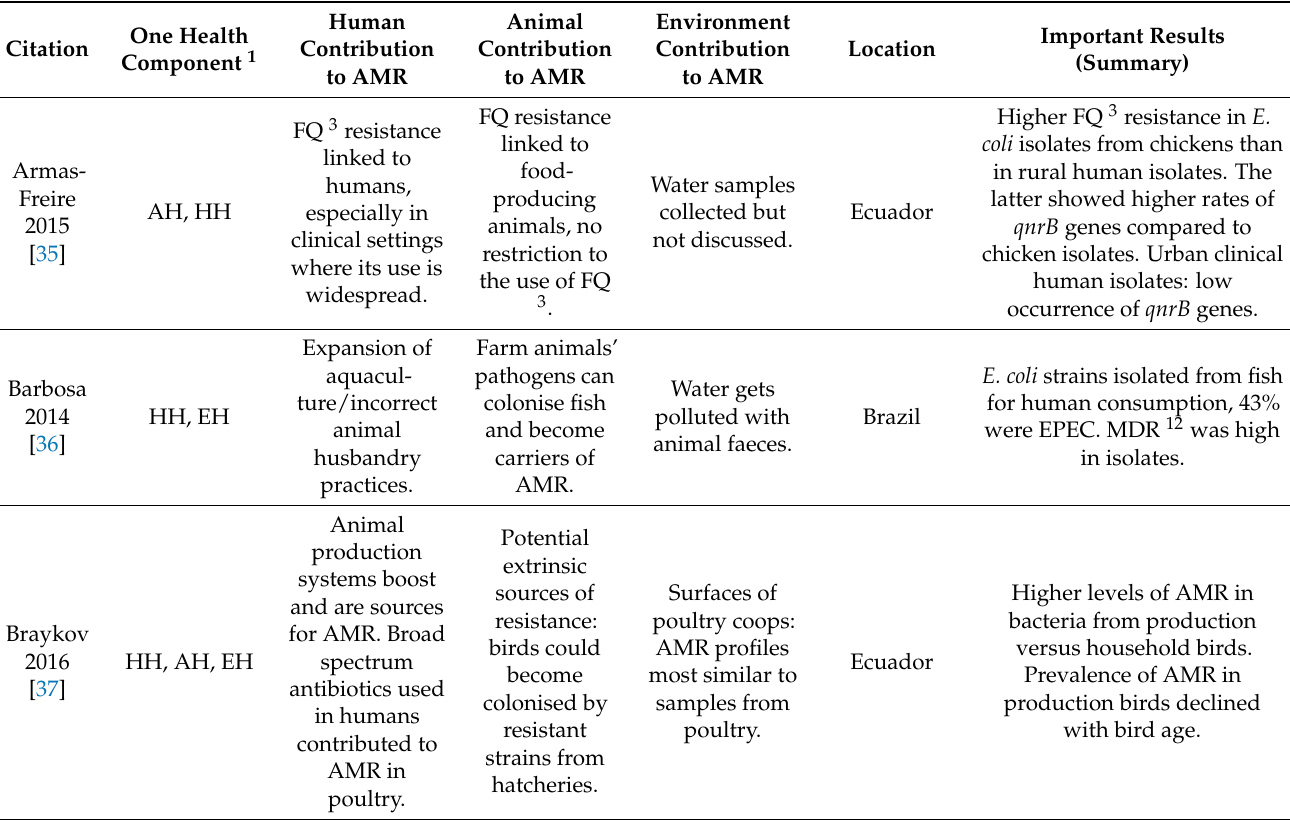
Table 1. Summary of selected